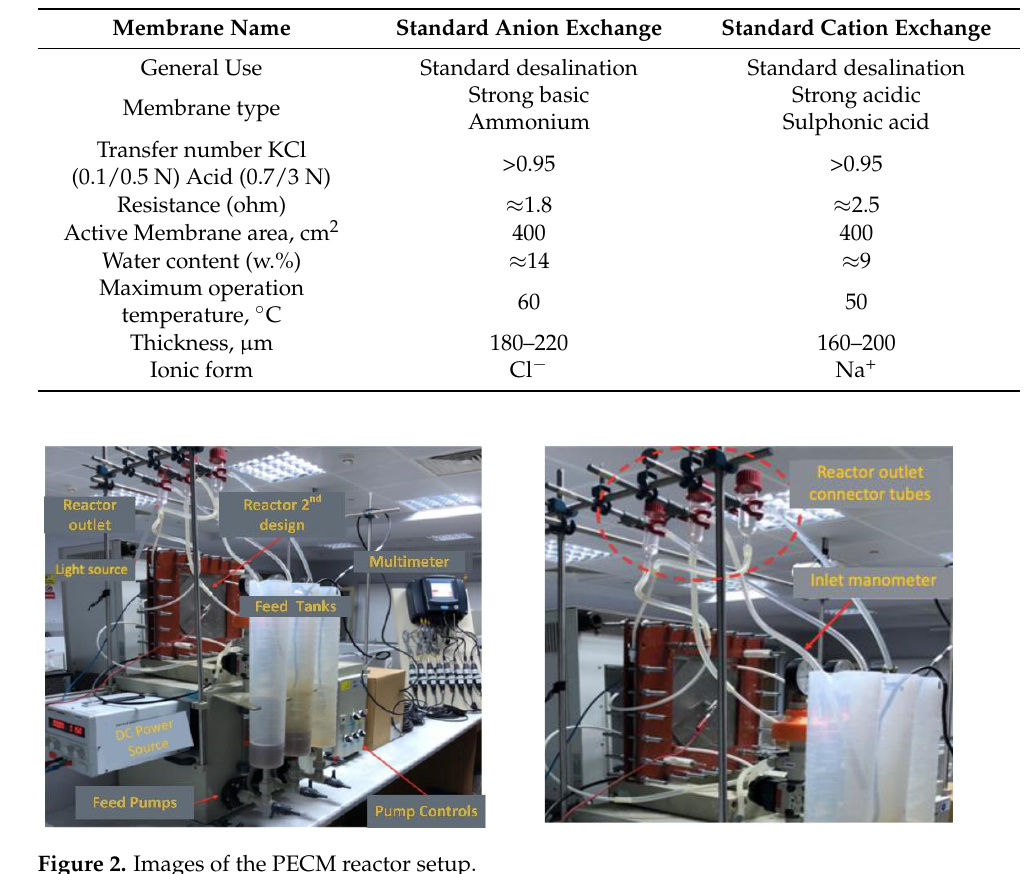
Figure 2. Images of the PECM reactor setup.